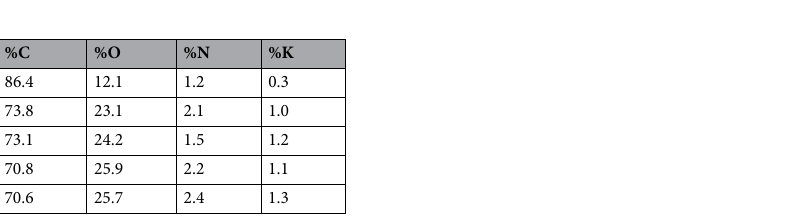
Table 2. Elemental surface composition in atom percentages for plasma treated nasturtium seeds.